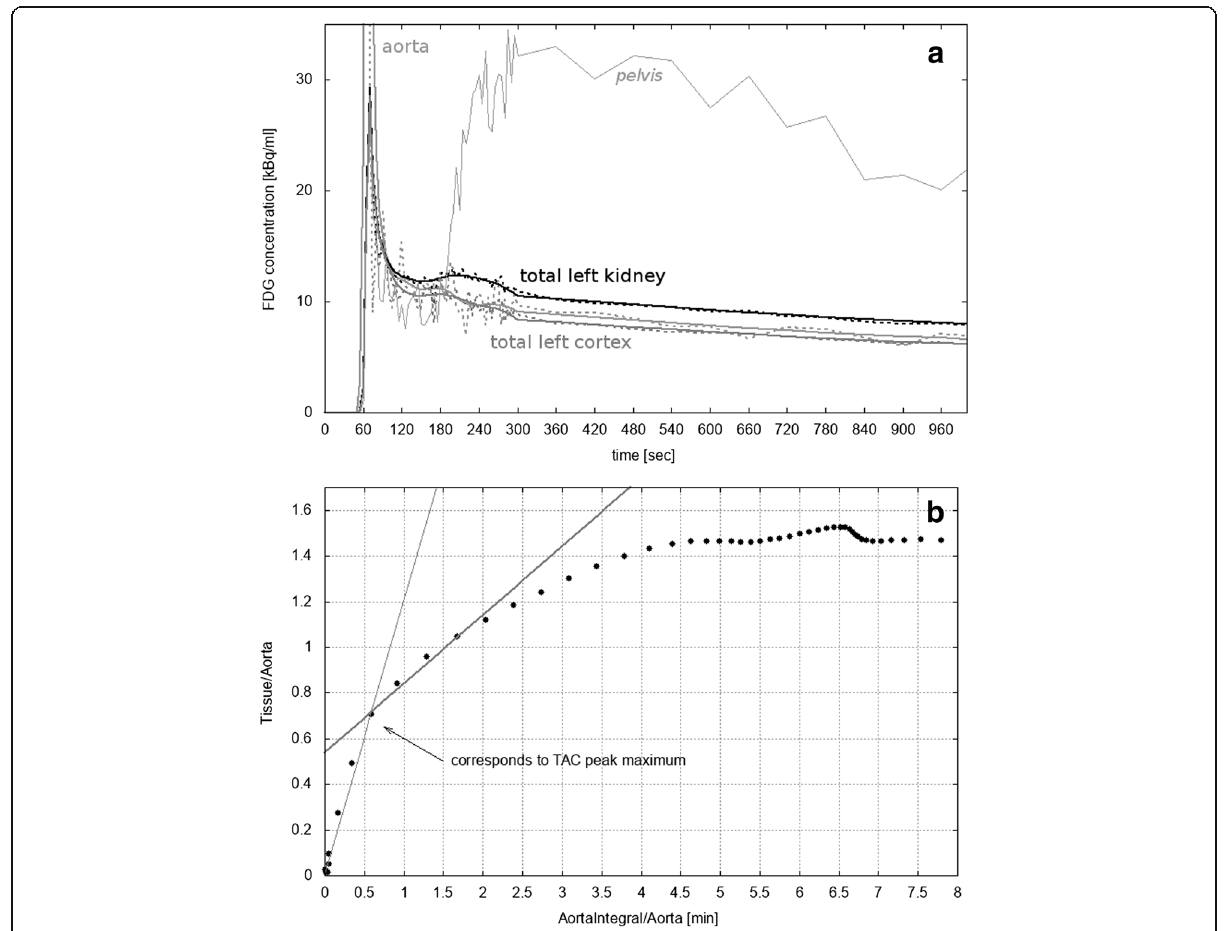
Fig. 3 a Typical smoothed left cortex (gray), left total kidney (black), and aorta (light gray) time activity curves (TACs). For the sake of visibility, the aorta peak is outside of range (maximum 157.8 kBq/ml) and only the first 1000 s are plotted. Original curves are added as dotted lines. The TAC of the renal pelvis is indicated with thin gray lines. b Patlak plot of the left total kidney TAC. Two linear fits are shown: the first from the first point to that one which corresponds to the peak maximum (thin gray line) and the second covering the linear segment below 2 min starting at the point corresponding to the peak maximum (thick gray line, slope 0.3 min − 1 , offset 0.54). The latter was used to calculate the FDG glomerular filtration rate (GFR FDG